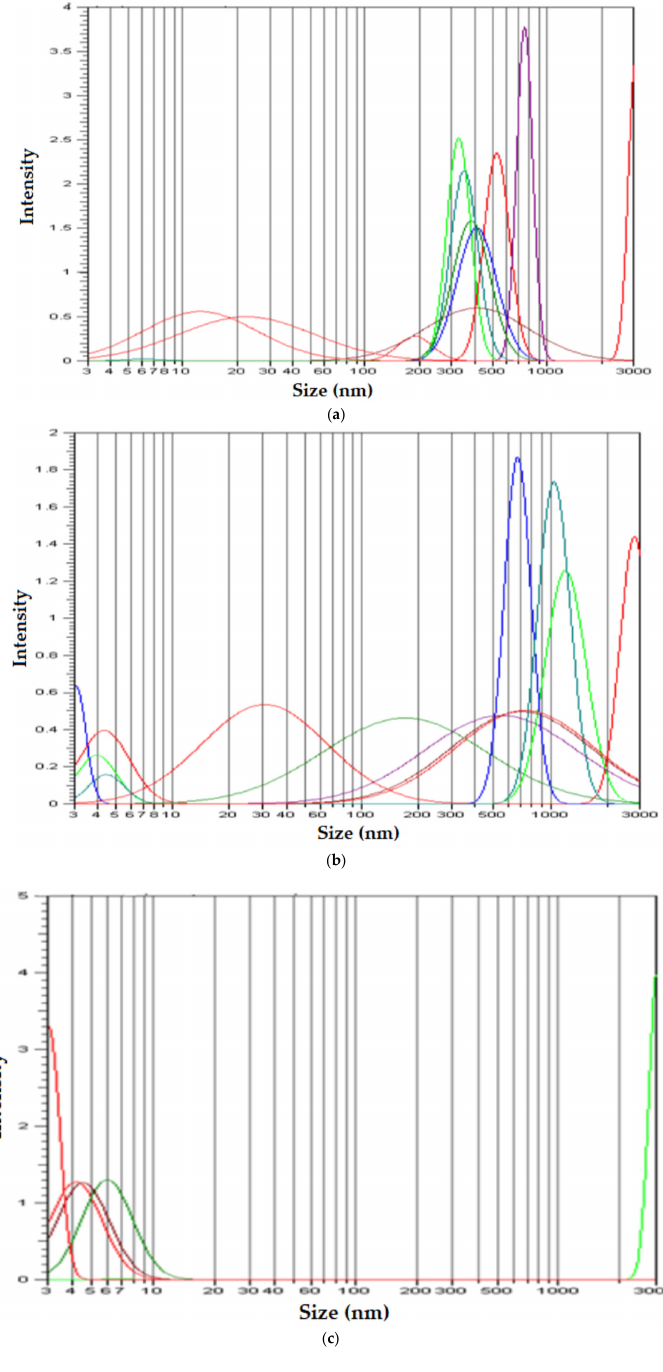
Figure 9. Size distribution of nanospecies in membrane nanodispersion: ( a ) initial nanodispersion; ( b ) nanodispersion after use in the reduction and transport process; ( c ) the initial nanodispersion subjected to ultrasound.